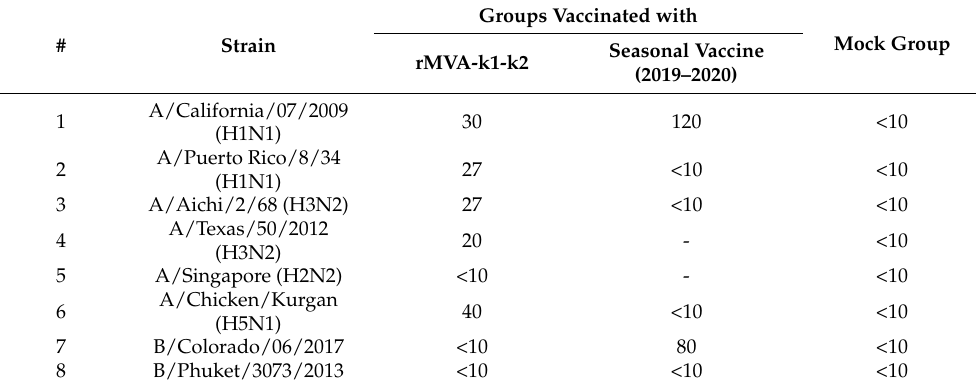
Table 4. HAI titer against 8 strains 14 days after the second